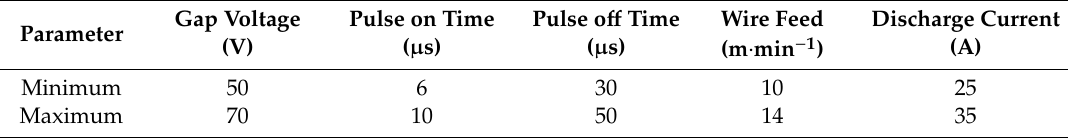
Table 1. limiting values of machine parameters setup.